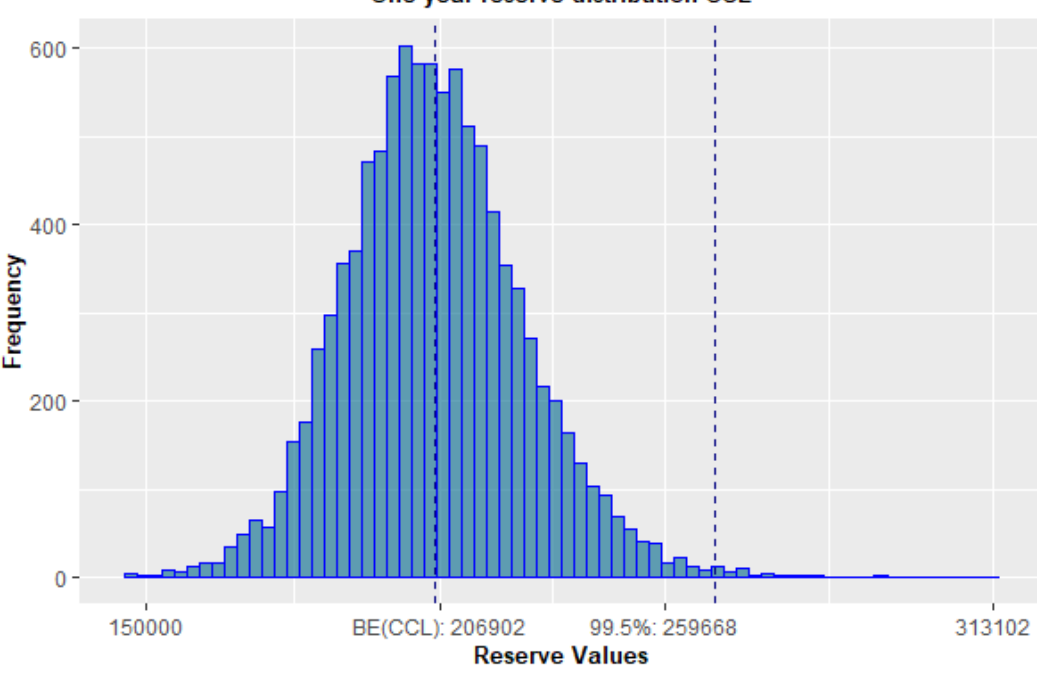
Figure 4. Distribution of the claims reserve over a one-year time horizon, obtained from 10,000 simulations. The lines represent the 99.5% quantile and the Best Estimate, respectively. By subtracting the Best Estimate from the quantile, we obtain the Solvency II capital requirement that represents the hypothetical SCR for reserve risk returned by this internal model. As reported in Table 6, this value is equal to 52,766.51. Amounts are in thousands of